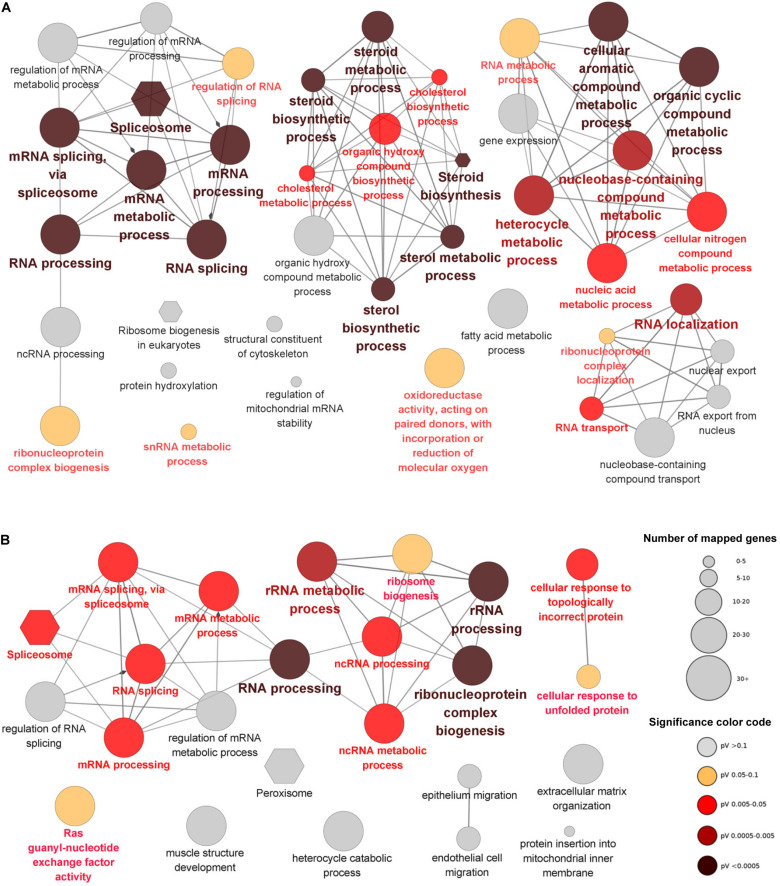
GO and KEGG enrichments for the DEGs identified from the brain (A) and the heart (B). The nodes represent the enriched GO (ellipse) and KEGG (hexagon) terms and the edges between nodes indicate the existence of shared genes. The size and color of nodes represent the number of associated genes and significance level of the functional terms.